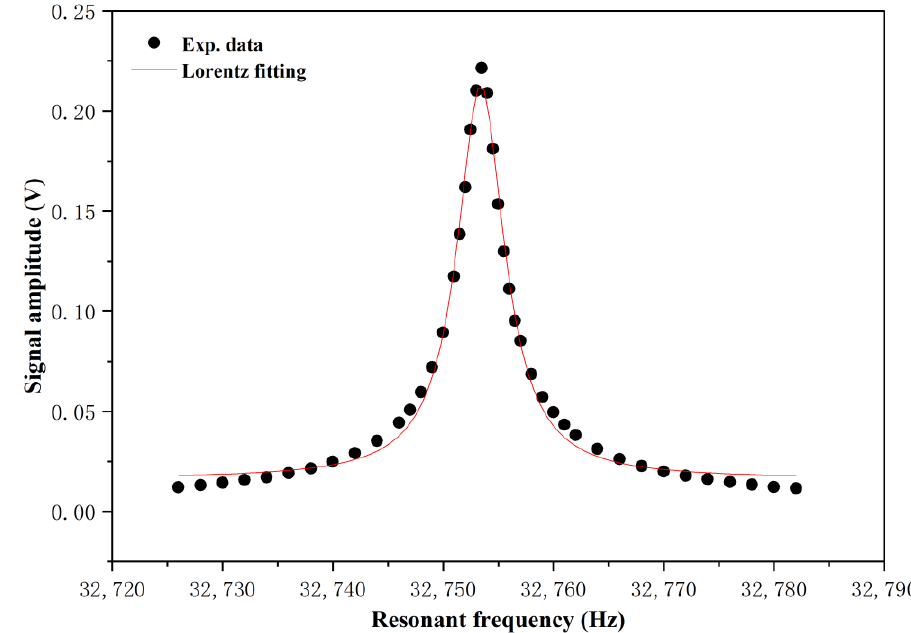
Figure 7. The measured QCTF resonant profile at ambient air and the Lorentz fitting. To further evaluate the gas sensor system, sulfur hexafluoride gas was used for the relevant experiments. Various sulfur hexafluoride samples with different concentrations were prepared for experimental tests. The whole experiment was carried out at room tem- perature and at a standard atmospheric pressure. At the beginning of the experiment, the gas sample cell was extracted to a vacuum environment to record the background signal for signal normalization processing analysis. Then, the sulfur hexafluoride sample was filled and diluted for signal spectra. In this study, the ECQCL laser emitted from 1130 cm − 1 to 1440 cm − 1 , with a step frequency of 1 cm − 1 /s. Experimental data were synchronously collected with an approximate 1 Hz sampling rate. To improve the spectral signal-to-noise ratio (SNR), the repetition rate of the ECQCL was set to match the QCTF resonance fre- quency (i.e., 32,753.4 Hz) as closely as possible, so as to achieve the maximum output power. According to the parameters mentioned above, it takes about 310 s to finish the whole wavelength tuning scan. Figure 8 (upper panel) shows the absorption spectra of sulfur hexafluoride gas under different concentrations. By comparing this to the reference spectrum in the NIST database as shown in Figure 1, the experimental data indicate that two distinct absorption bands of sulfur hexafluoride near 1257 cm − 1 and 1390 cm − 1 , respec- tively, have been confirmed. However, a weak absorption peak near 1355 cm − 1 is not found in the experimental data. Note that this weak absorption peak near 1355 cm − 1 is also not found in a previous publication reported by Chapados et al. [11]. Moreover, the sensor system characteristic of concentration response was also evaluated by selecting the ab- sorption peaks at 1257 cm − 1 and 1390 cm − 1 , respectively, as shown in Figure 8 (bottom panel). A linear regression algorithm was used to analyze the experimental data. As the theory predicted, a good linear dependence of the absorption signal at 1257 cm − 1 and 1390 cm − 1 on SF 6 concentration was obtained, with a regression coefficient R 2 of 0.9997 and 0.99264, respectively. The results indicate that the ECQCL gas sensor system is propor- tional to the concentration of the absorbing molecule, and the calibration curve can be used for determining the gas concentration of an unknown sample. Figure 8. Experimentally measured SF 6 spectra (upper panel) and signal amplitude at 1250 cm − 1 and 1390 cm − 1 as a function of sample concentrations (bottom panel), and the corresponding linear